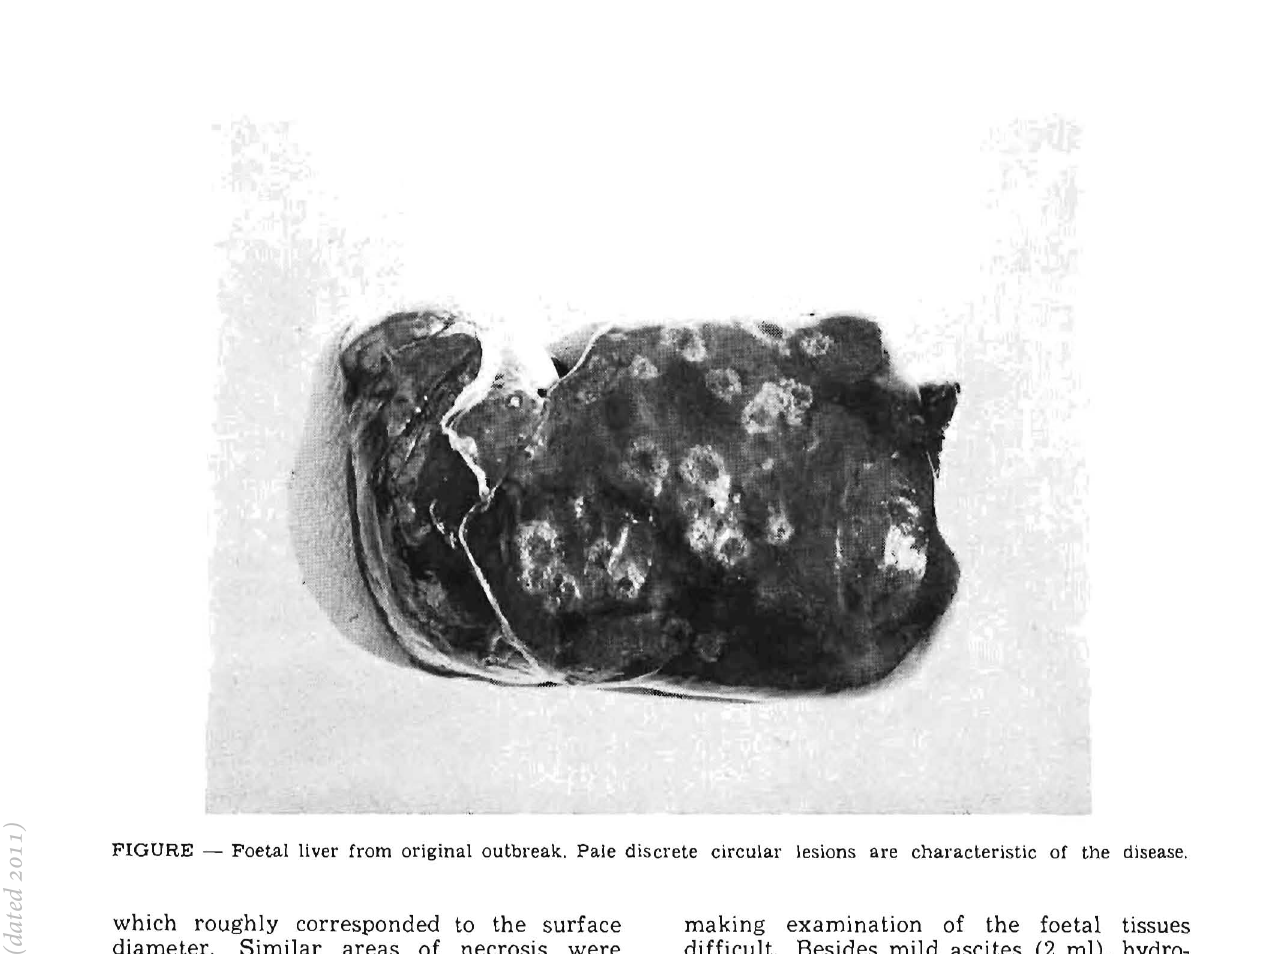
FIGURE - Foetal liver from original outbreak. Pale discrete circular lesions are characteristic of the disease.